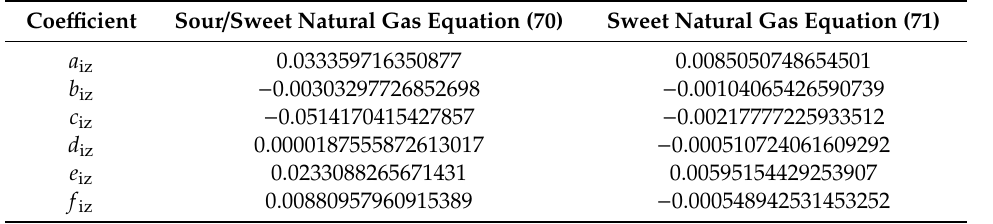
Table 8. Values of coe ffi cients in Equations (70) and